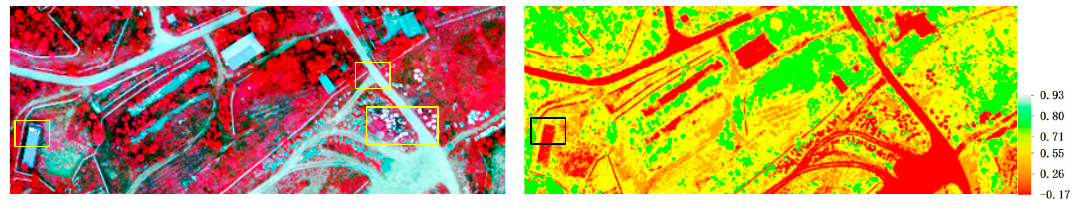
Figure 6. Image pairs of Sequoia (10 cm) after data processing: ( a ) the false color composite formed by the combination of near-infrared, red, and green bands; ( b ) normalized difference vegetation index (NDVI) product of Sequoia.